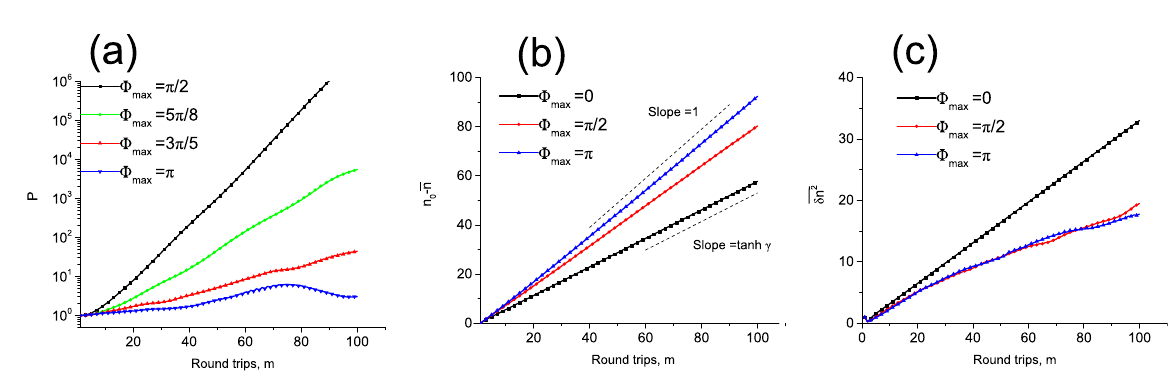
Figure 4. Propagation of an initially localized pulse in different models (log 10 | a n | shown): ( a ) Pure HN model ( Φ max = 0, γ = ln2), ( b ) RC ( Φ max = π , γ = 0), ( c ) GHN with ring topology ( Φ max = π , γ = ln2). The black dashed lines bound a causality cone while the white line in ( a ) marks the theoretical prediction of the group velocity (see main text).